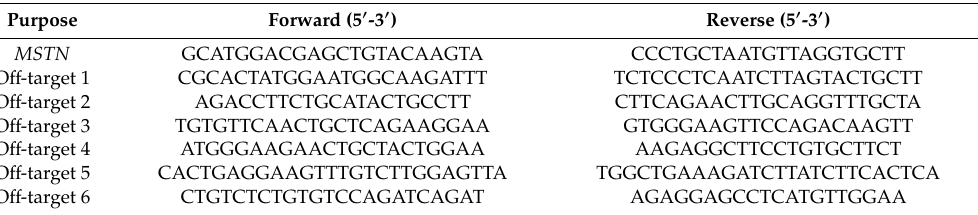
Table A2. List of primers used in the present